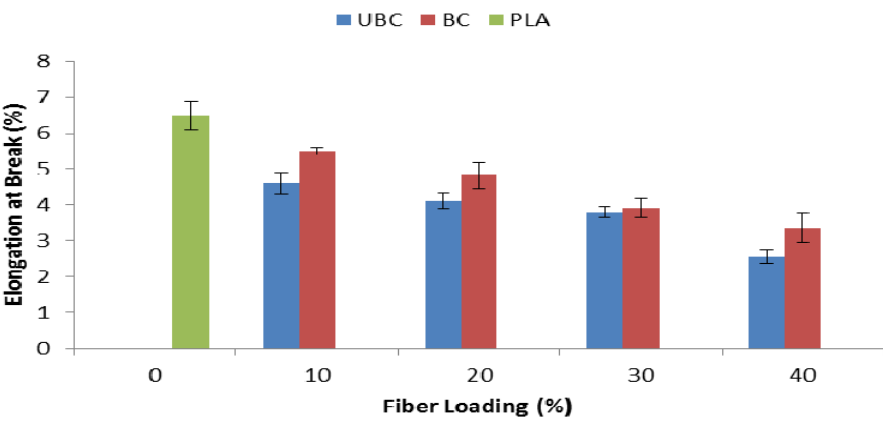
Figure 6. Elongation at break of pure PLA, UBC and BC composites.